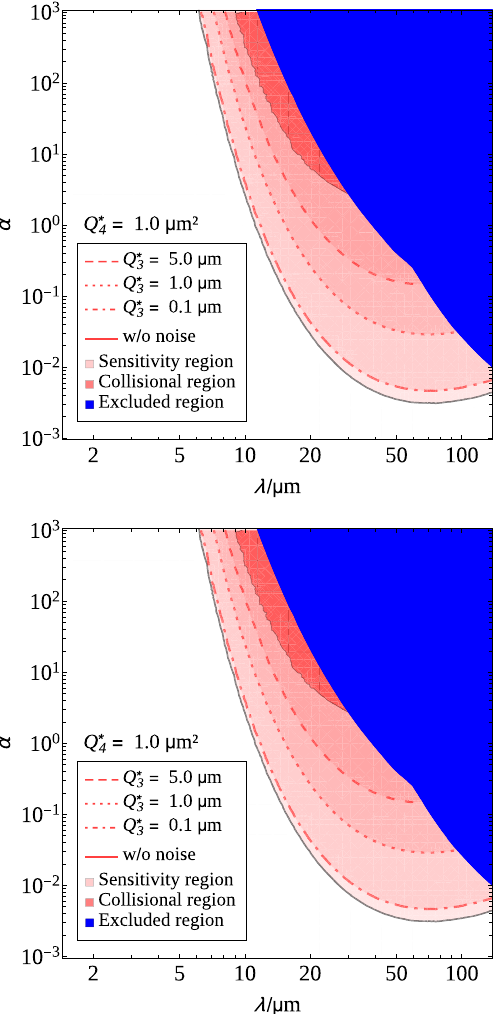
Fig. 14 Sensitivity of the proposed experimental setup in the ( λ,α ) plane in the presence of Q i attractive backgrounds with 1 / r , 1 / r 2 and 1 / r 3 dependence which are only known to be smaller than some upper limits Q i . The blue region represents the present experimental bounds (see Fig. 3). The red-meshed region is the part of the parameter space for which a Beyond-Newtonian potential will induce collision between S and P. The pink-shaded region is the part of the parameter space for which we would detect precession in the presence of New Physics, expected to be large enough to be distinguishable from the signal induced by the backgrounds (and that can be thus excluded at 95% CL in the case no signal is observed). The boundary of the sen- sitivity region is drawn for values of λ and α for which we expect the